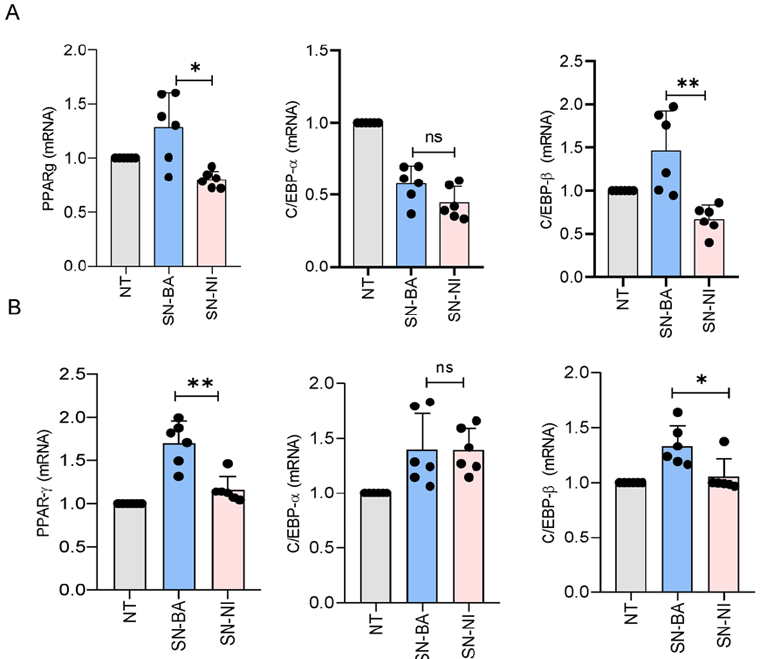
Figure 8. B. abortus -infected osteoblasts modulate adipocyte transcription factors. Effect of infected culture supernatants on peroxisome proliferator-activated receptor γ (PPAR- γ ), CCAAT enhancer binding protein α (C/EBP- α ), and β (C/EBP- β ) transcription determined by RT-qPCR in adipocytes at days 1 ( A ) and 14 ( B ) post-stimulation. NT: non-treated. * p < 0.001, and ** p < 0.001 vs. cells treated with culture supernatants from non-infected cells (SN-NI). ns: non-significant.